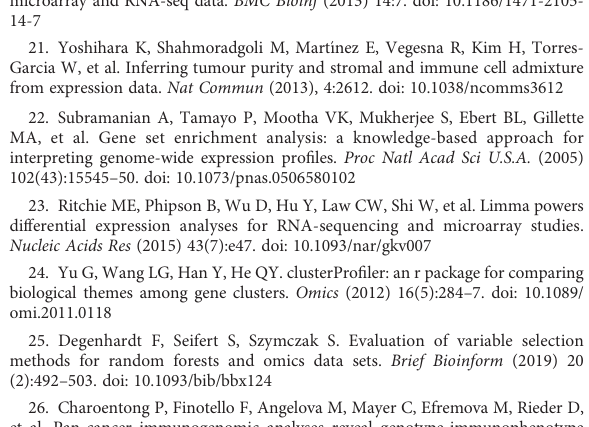
SUPPLEMENTARY FIGURE 4 Differences in clinicopathological and biological features between two gene subtypes. (A) Expression differences of 31 CSRGs between the two gene subtypes. (B) Heatmap of the distribution of clinicopathological features and CSRG expression between two different gene subtypes. CSRG, cuproptosis subtypes related gene; ***p < 0.001.